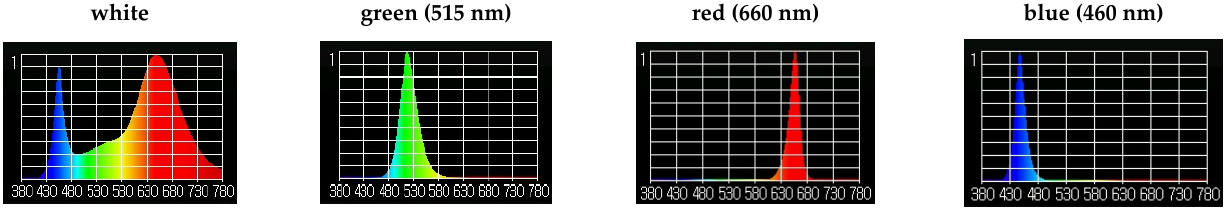
Figure 3. Graphs of LED light spectra used to evaluate the effects of monochrome LED on S. rebaudiana microshoot growth.